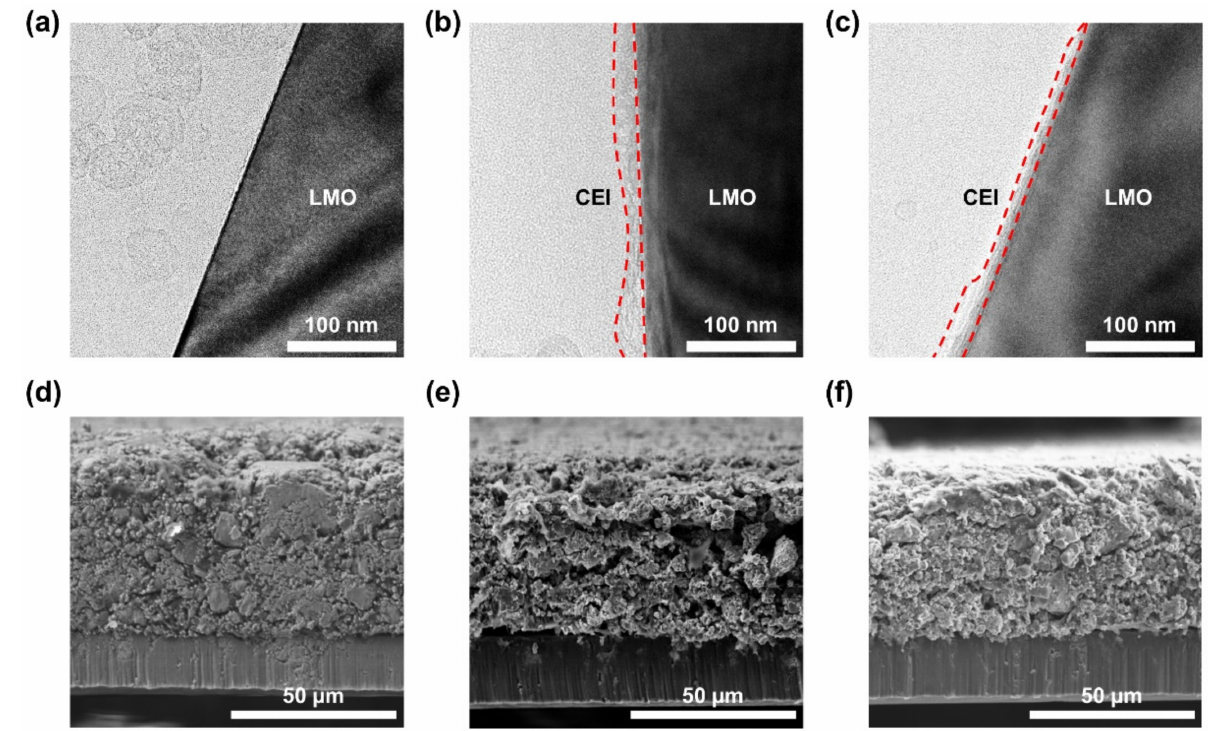
Figure 3. TEM images of LMO cathodes ( a ) before cycling and after cycling 100 times with ( b ) the base and ( c ) P2 electrolytes. Cross-sectional SEM images of LMO cathodes ( d ) before cycling and after cycling 100 times with ( e ) the base and ( f ) P2